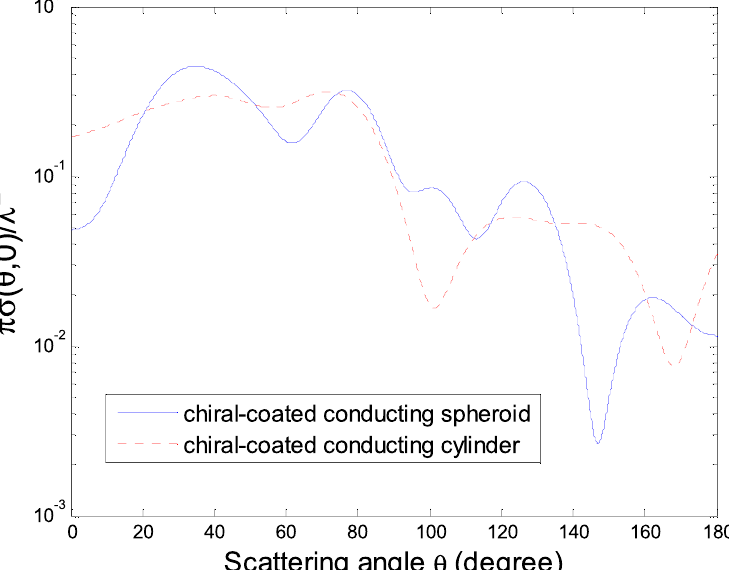
Figure 6. Normalized DSCS πσ ( θ , 0)/ λ 2 for a chiral-coated conducting spheroid and that for a chiral-coated conducting circular cylinder respectively as in Figs 2 and 3, under the illumination of the HED radiation ( x 0 = 2 λ , y 0 = z 0 = 0, α = π /6, β = π